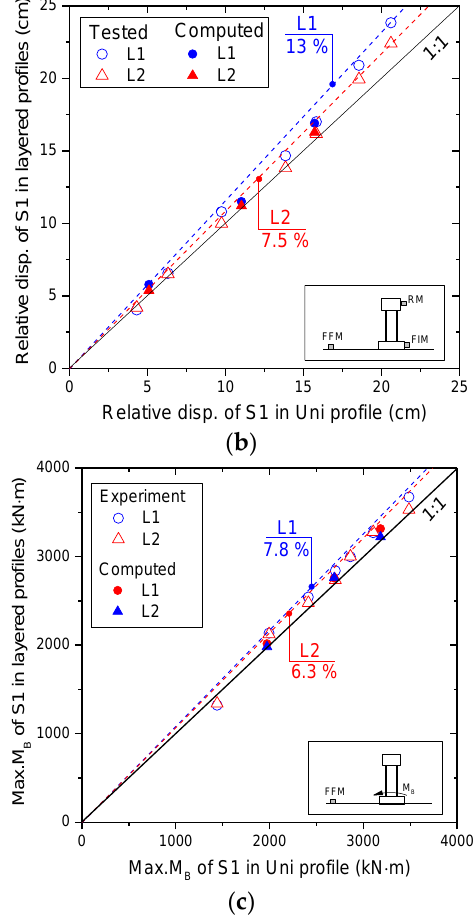
Figure 11. Comparison of the maximum of ( a ) acceleration of RM, ( b ) relative displacement of the roof, and ( c ) bending moment at the bottom (Max.MB) for the S1 structure on L1 and L2 profiles with those on Uni profile.